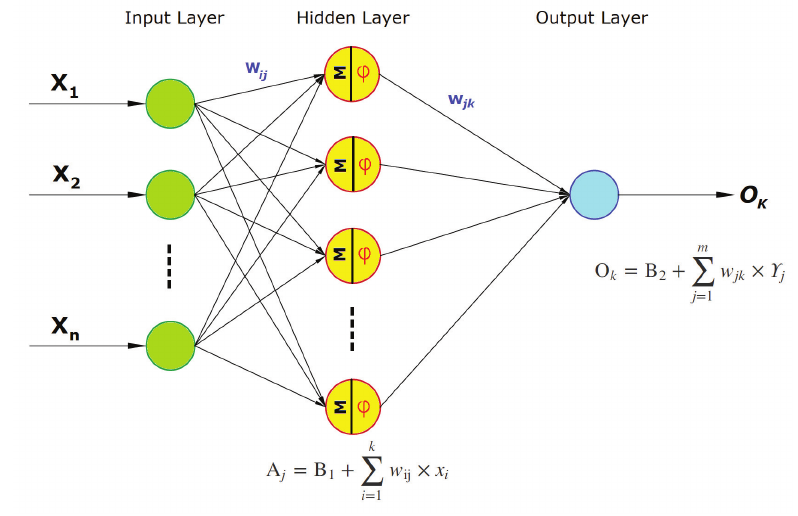
Figure 1. Artificial neural network (MLP)